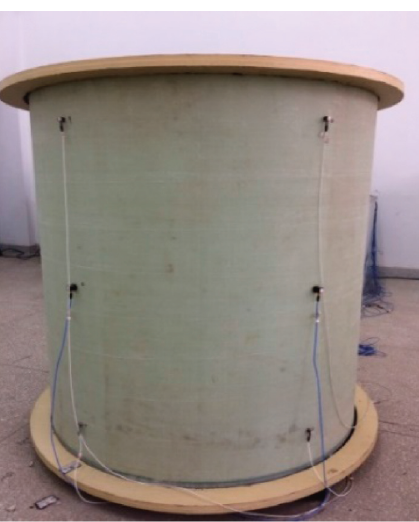
Figure 1: Experimental model of a laminated composite cylindrical